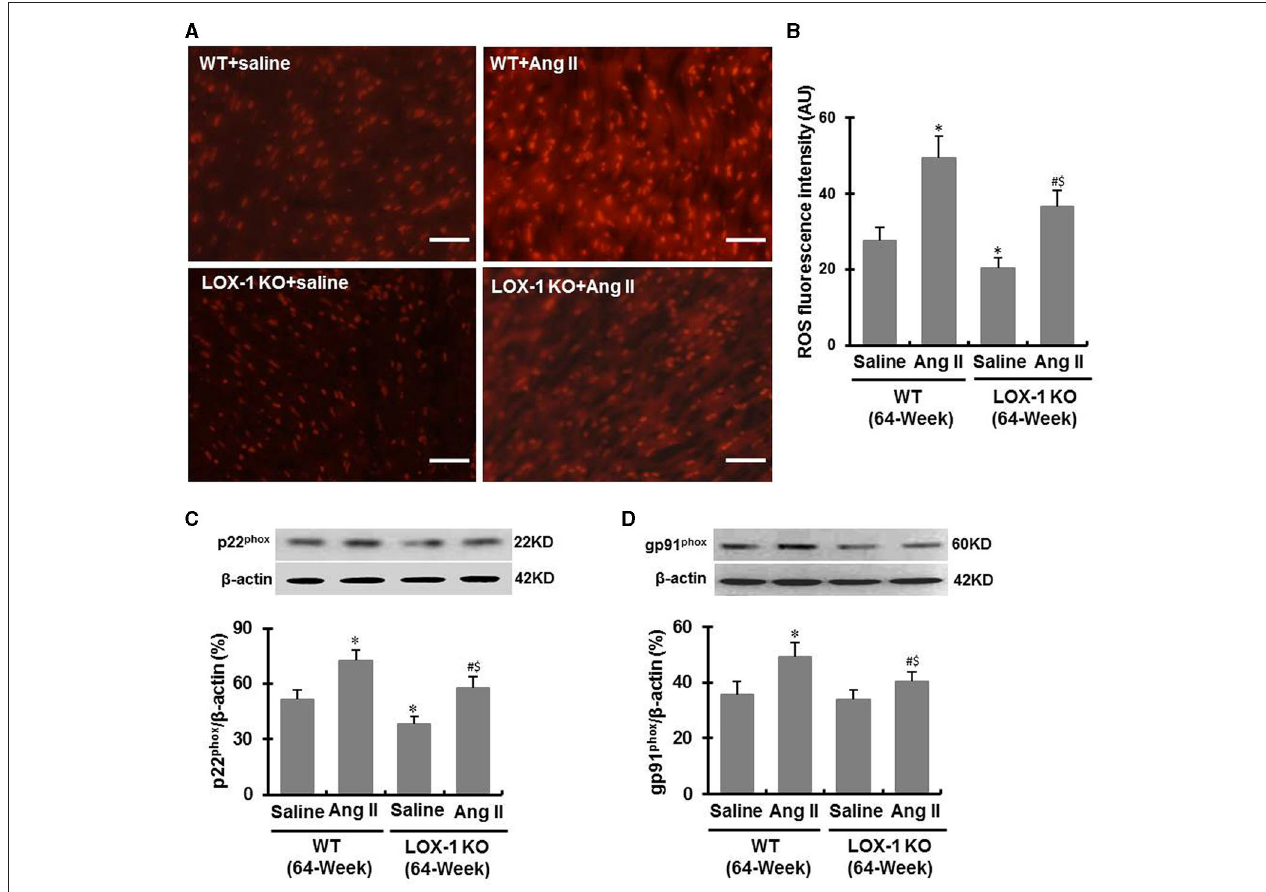
FIGURE 7 | ROS level and expression of p22 phox and gp91 phox in the ventricle of each group of mice following infusion with Ang II or saline for 4 weeks. (A) Representative DHE staining images shows ROS level in the ventricle of each group of mice; (B) Quantitative data of DHE staining images; (C) Western blotting data show p22 phox expression; (D) Western blotting data show gp91 phox expression. n = 6 /group. * P < 0.05, vs. WT + saline group; # P < 0.05, vs. LOX-1 KO + saline group; $ P < 0.05, vs. WT + Ang II group. Scale bars represent 50 µ